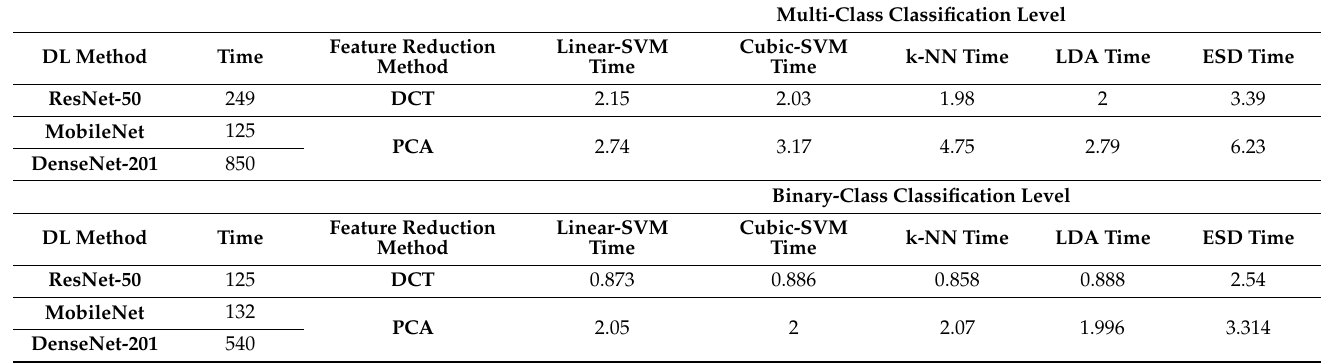
Table 11. The training execution time (sec) of the three CNN used in MB-AI-His CADx and after the fusion stage of MB-AI-His CADx for both binary and multi-class classification